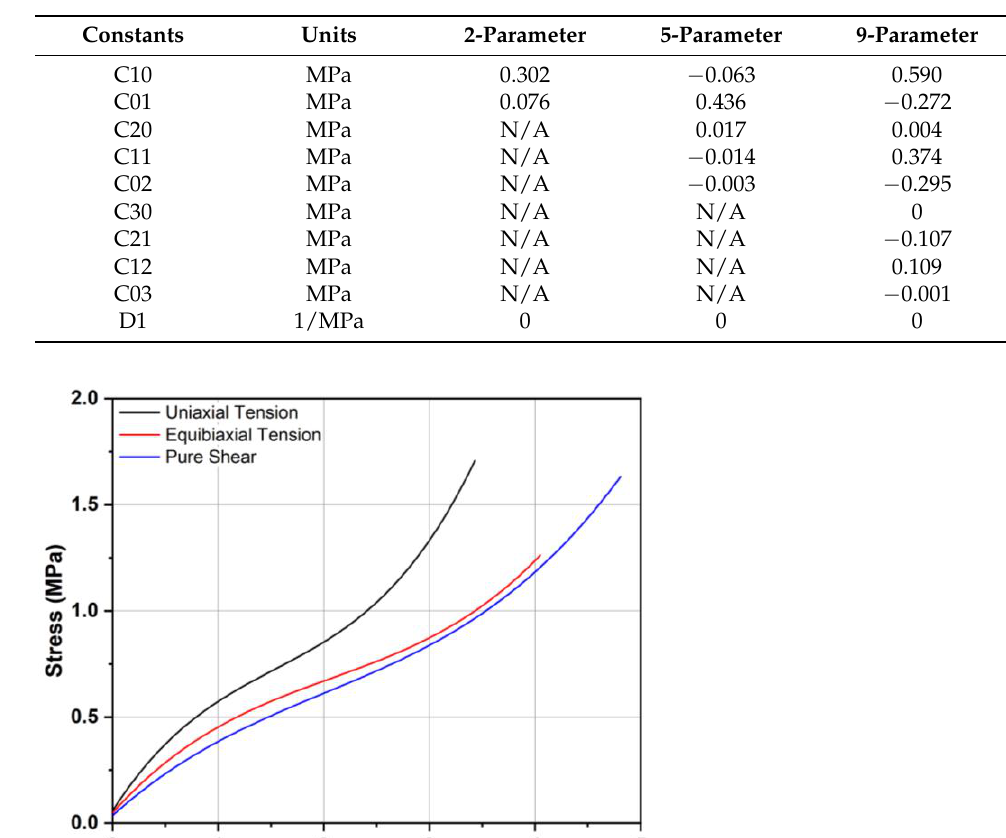
Table 5. Mooney–Rivlin constants for neoprene sheet (Shore 50A).